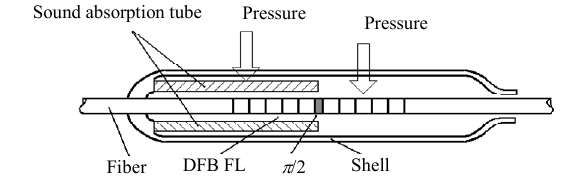
Fig. 4 Asymmetrical structure of DFB fiber laser acoustic